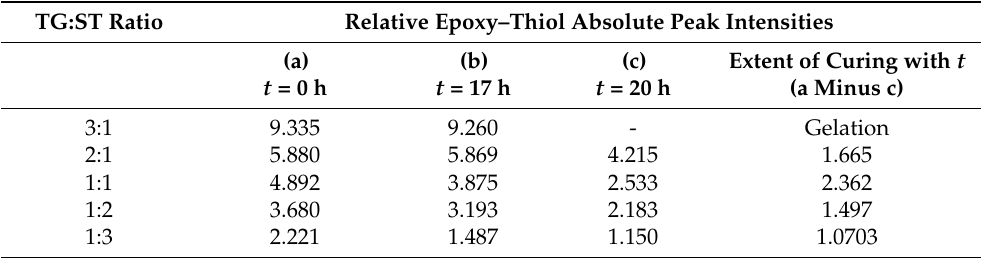
Figure 2. Raman spectra showing the variation of epoxy and thiol peaks for reaction of TGST at ( a ) 0 h, ( b ) 20 h, and for LA(TGST) at ( c ) 20 h. ( d ) Extent of curing shown by the relative intensities of epoxy and thiol moieties with increasing TG:ST/LA(TG): LA(ST) ratios at different crosslinking times. Table 1. Variation of extent of curing in TGST formulations with changing epoxy–thiol stoichiometry. TG:ST